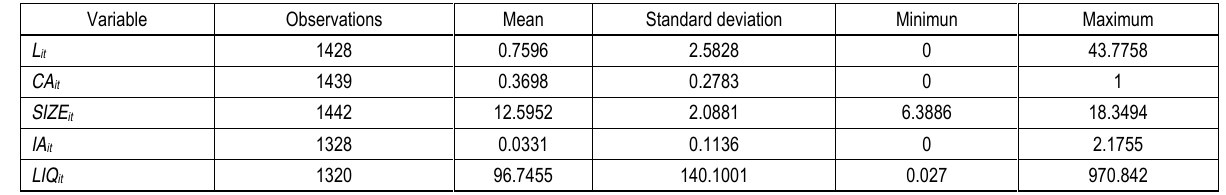
Table 3. Descriptive statistics, Model I